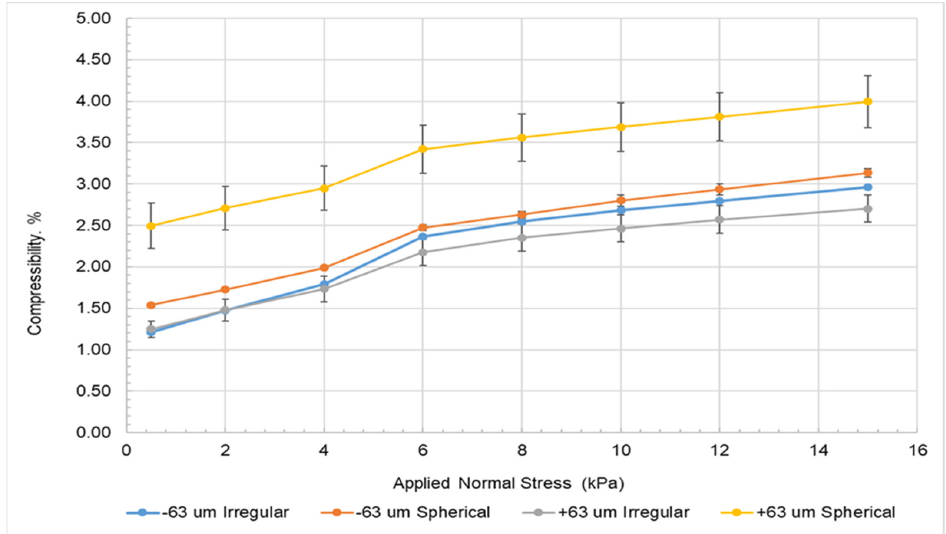
Figure 10. FT4 compressibility as a function of normal stress.